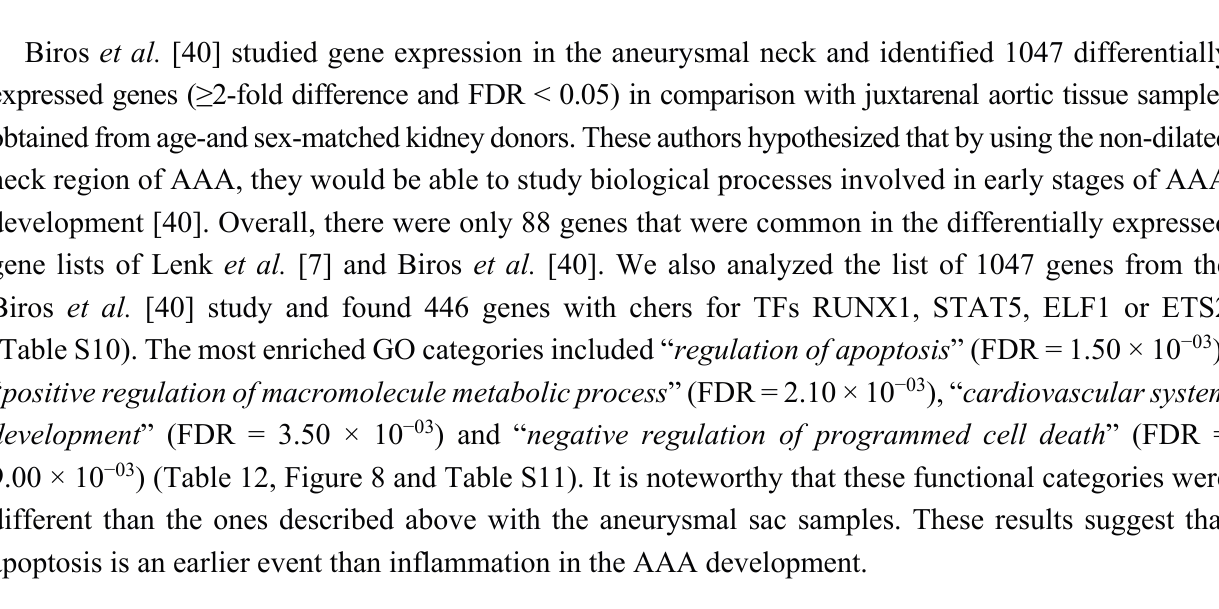
Table 12. Enriched GO biological process categories for the target genes differentially expressed in the AAA neck and found to have binding sites for transcription factors RUNX1, ELF1, ETS2 and STAT5 based on the current ChIP-chip